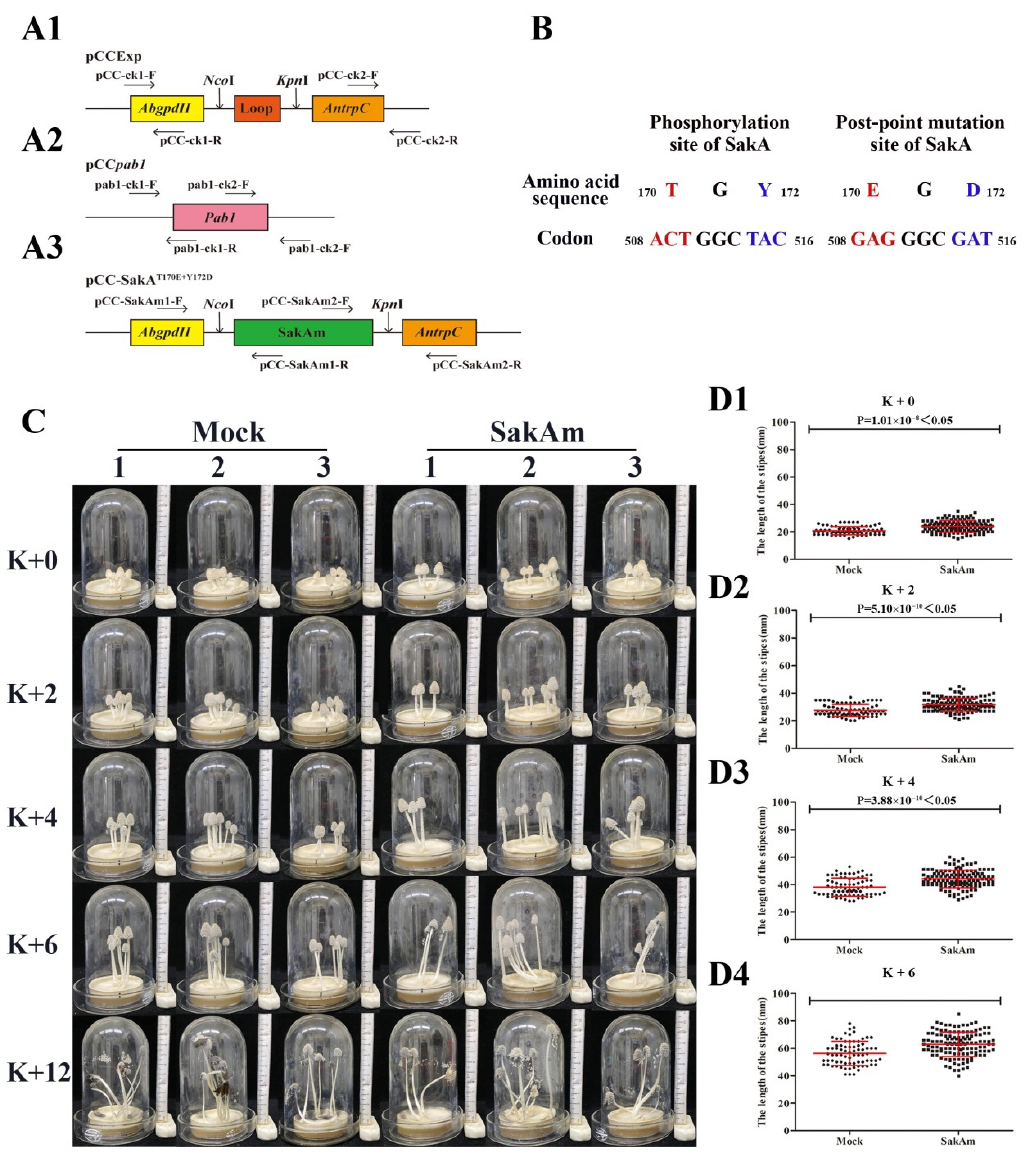
Figure 3. Construction and phenotypes of CcSakA phosphomimicking mutant strains. ( A ) Schematic representation of plasmids pCcExp ( A1 ), pCc pab-1 ( A2 ), and pCC-SakA T170E+Y172D ( A3 ). The arrows below the plasmids indicate the primers for genomic PCR. ( B ) Schematic diagram of SakA phos- phorylation site mutations. ( C ) Growing fruiting bodies of the three representatives of the mock transformants and SakAm transformants at different time points. ( D ) The stipe lengths of the fruiting bodies of four mock transformants (circle, n = 123 fruiting bodies) and eight SakAm transformants (square, n = 131 fruiting bodies) with at least three repeats of each transformant at K + 0 ( D1 ), K + 2 ( D2 ), K + 4 ( D3 ), and K + 6 ( D4